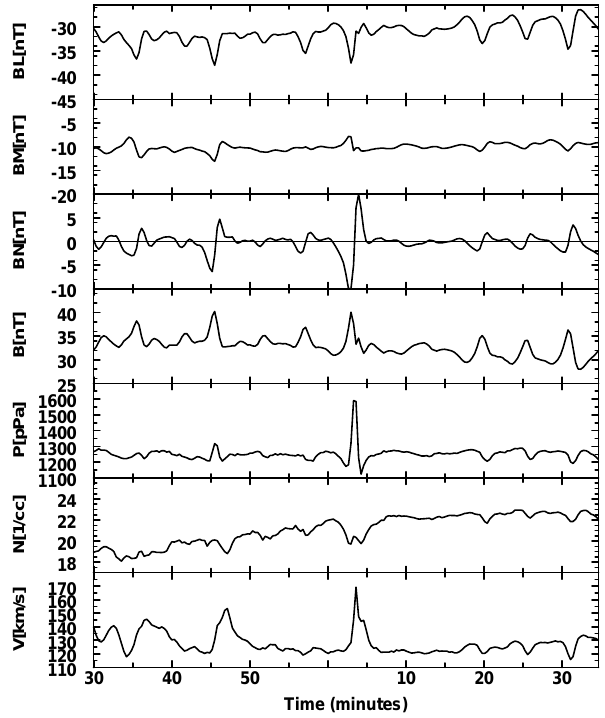
Fig. 5. Time traces of a virtual satellite taken at 9.8 R E geocentric distance and –30 ◦ GSE latitude. This location is roughly at the center of the magnetosphere, in the magnetosheath, and close to the magnetopause. The panels show, from top to bottom, the L, M, and N components of the magnetic field (see text for details), the total field, the plasma pressure, the plasma density, and the plasma velocity. There are clear dipolar signatures in the magnetic field N component at 35, 57, 04, 20, 26, and 32min.